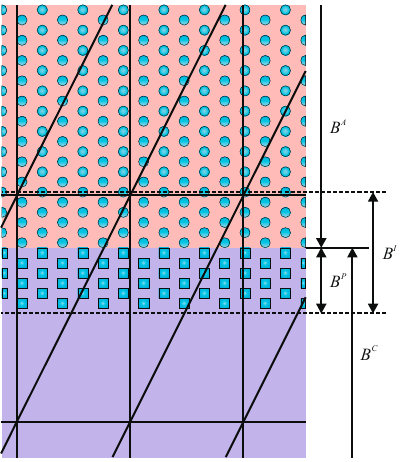
Figure 14. The BSM interfacial region. The interface has no handshake region and the finite elements cover the entire body which allows to store the coarse scale displacement field.